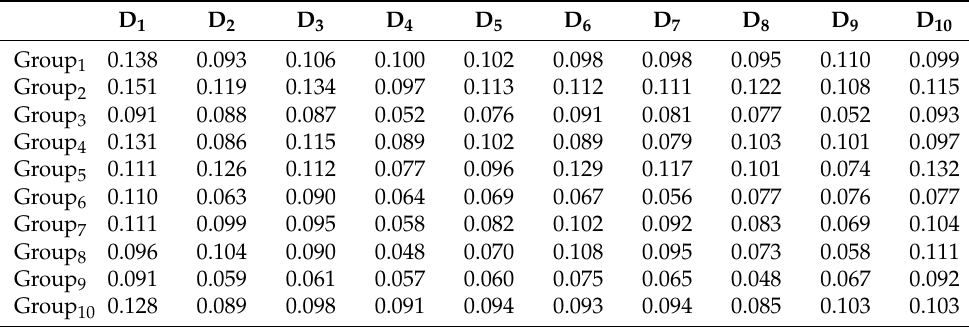
Table 12. Aggregated distances with the IOWAD operator.